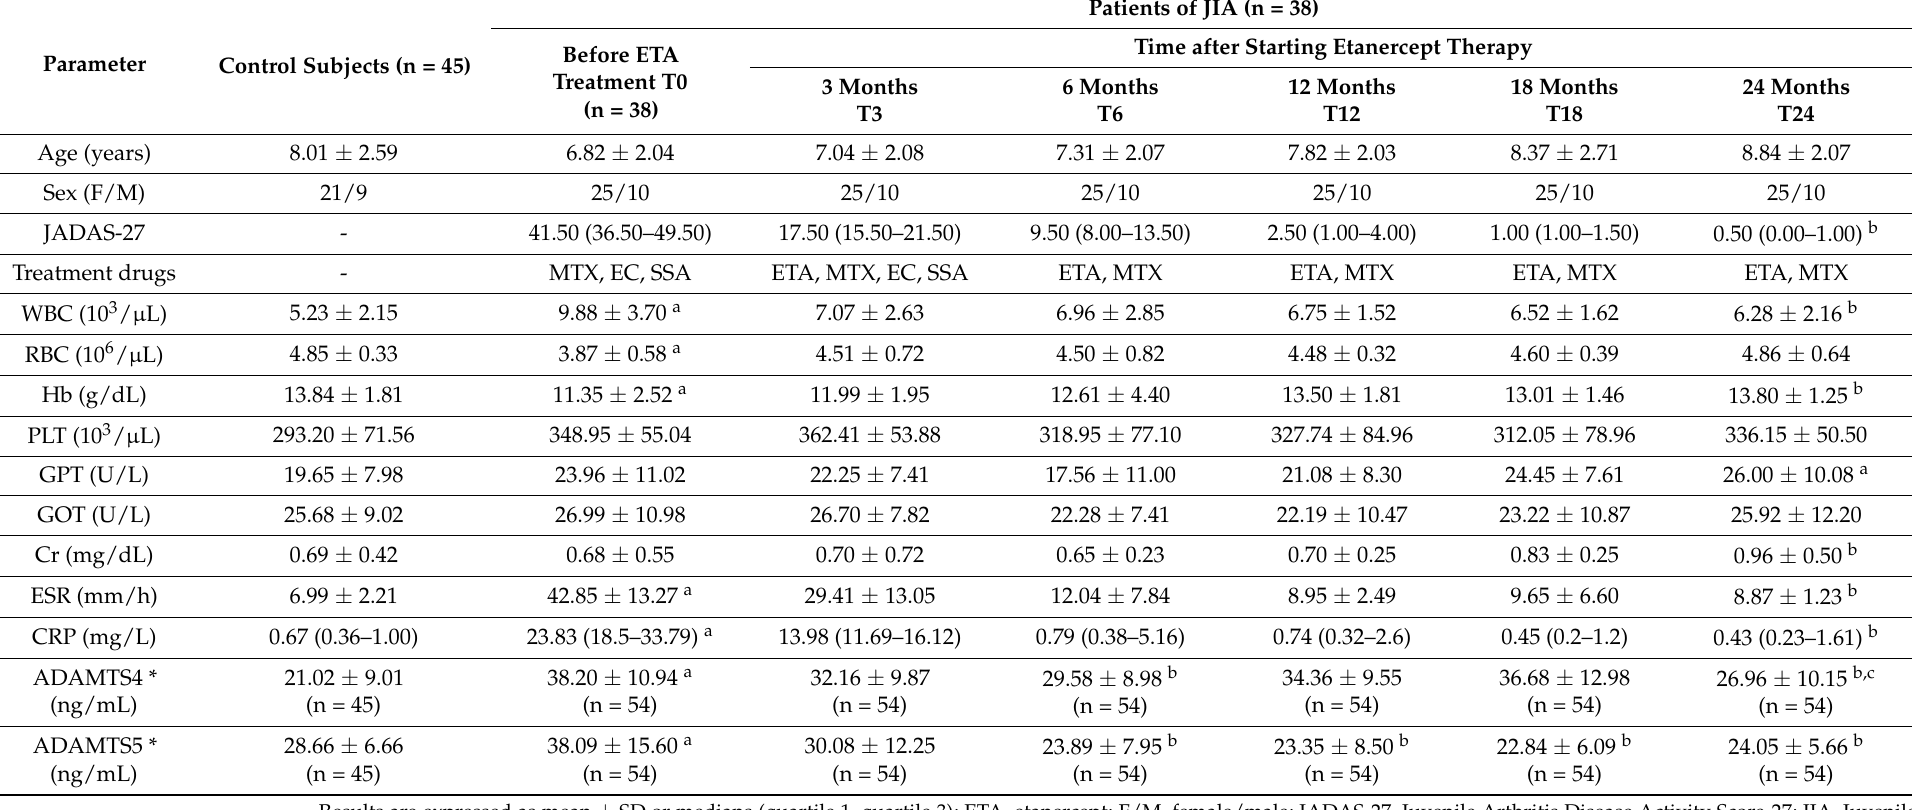
Table 1. Clinical data of healthy patients and patients on biological